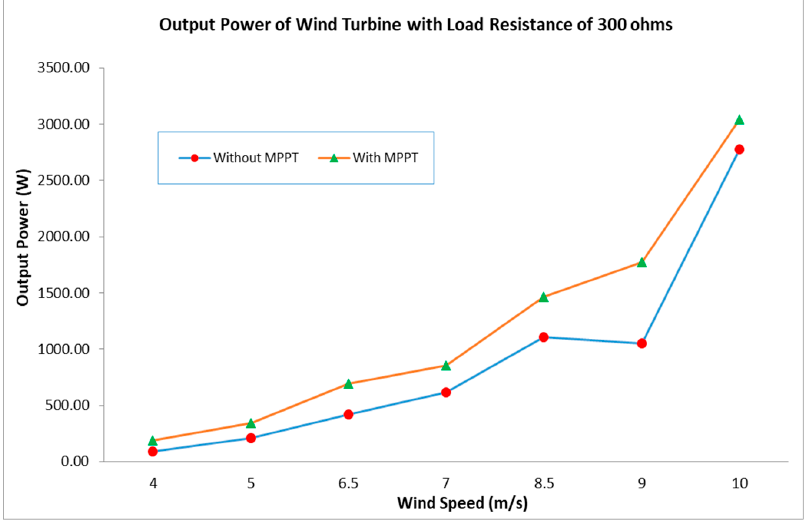
Figure 17. Output power of wind-turbine system with load resistance of 300 Ω .